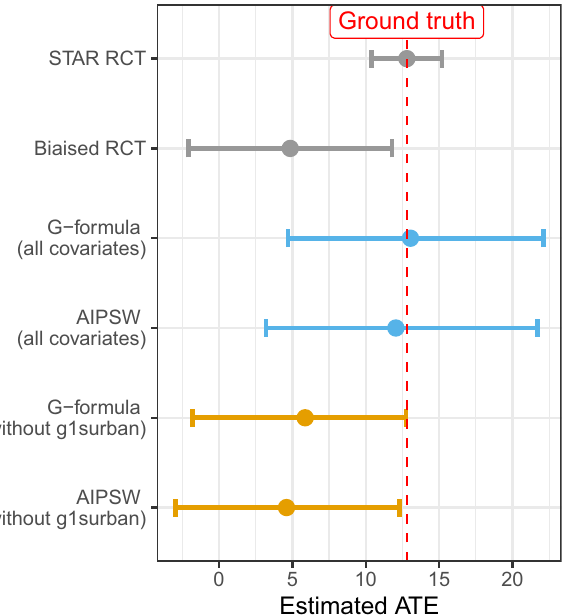
Figure 8: Simulated STAR data : True target population ATE estimation using all the STAR ’ s RCT data is represented ( di ff erence - in - means ) . This is highlighted with a red dashed line to represent the ground truth. The ATE estimate of a biased RCT ( di ff erence - in - means ) is also represented showing a lower treatment e ff ect due to a covariate shift along the covariate g1surban . Two estimators are used for the generalization, the G - formula ( De fi nition 1 ) and the AIPSW ( De fi nition A2 ) ; both relying on linear or logistic models for the nuisance components. The generalized ATE is either estimated with all covariates ( blue ) or with all covariates except g1surban ( orange ) . The con fi dence intervals are estimated with a strati fi ed bootstrap ( 1,000 repetitions ) . Similar results are obtained when nuisance components are estimated with random